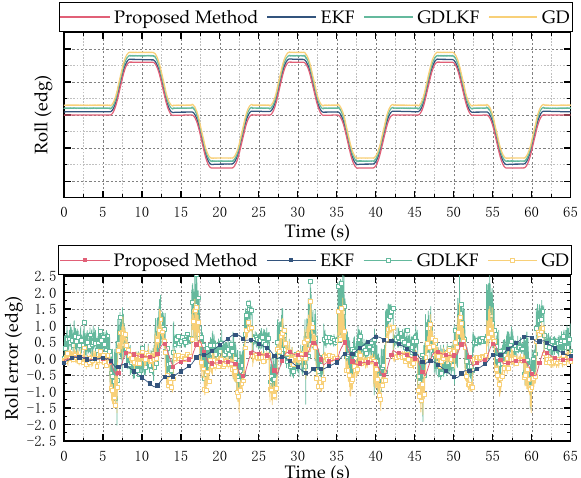
Figure 12. Hardware-in-the-loop simulation test results of roll angle. The above is a comparison of the estimation results of different methods, and the bottom is the error between the estimated value of different methods and the reference value.